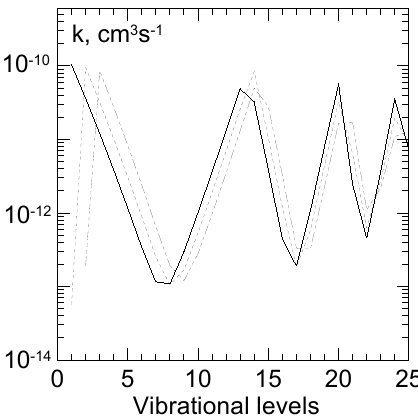
Fig. 12. The calculated total quenching rate coefficients of O 2 ( a 1 1 g , v )+O 2 (X 3 6 − g , v =0, 1, 2) at a temperature of 300K Figure 12. The calculated total quenching rate coefficients of O 2 (a 1 ∆ g ,v) + O 2 (X 3 Σ g– ,v=0,1,2) at (solid, dotted and dotted-dashed lines, respectively). temperature of 300 K (solid, dotted and dotted-dashed lines, respectively)